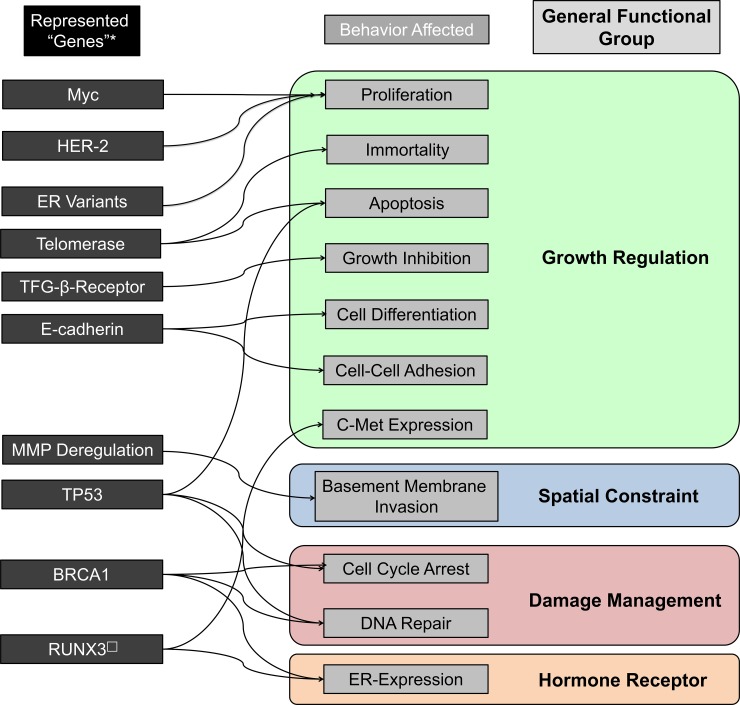
Overview of gene-function relationships in the Duct Epithelium Agent-based Model (DEABM).Mutations to individual genes can have single or multiple effects on cellular behavior. Gene-function categories in the DEABM can be generally grouped into the categories of growth regulation, spatial constraint, damage management and hormone receptor function. In order for cells in the DEABM to acquire the behavioral hallmarks of malignancies, multiple mutations in multiple categories must be acquired.